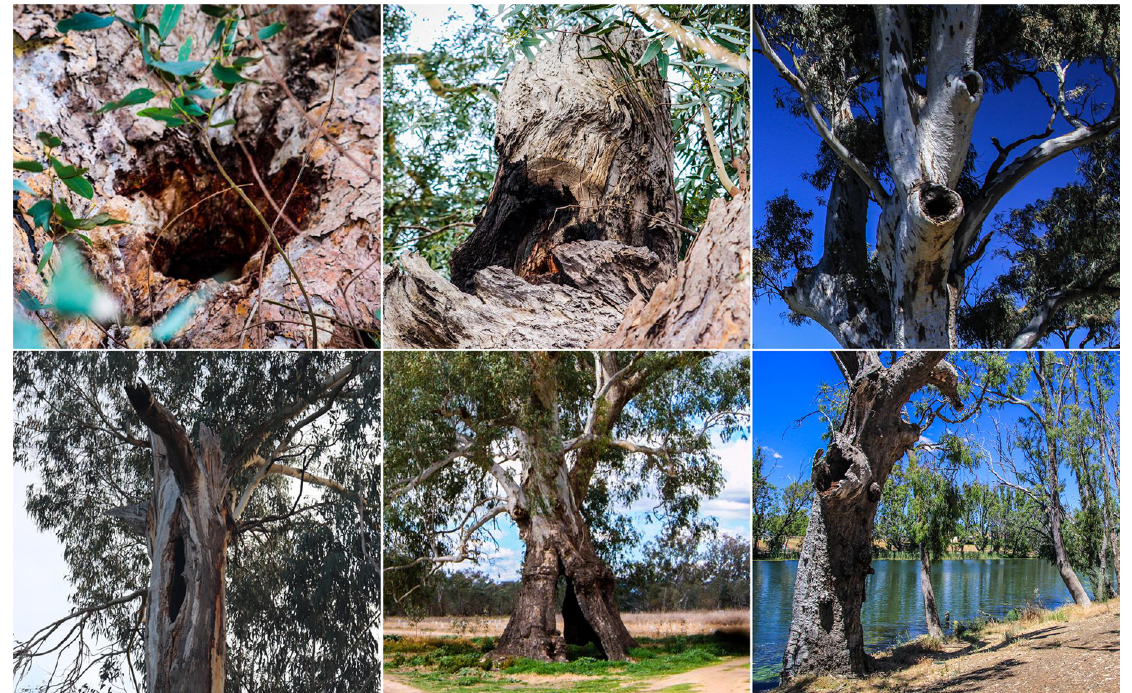
Fig. 5 Hollows in large old river red gums. Top left: a small cavity. Top middle: hollow from a lightning strike. Top right: a large hollow from fallen branches (image by Colin Judkins). Bottom left: a large fissure and a protruding hollow. Bottom middle: a root cavity enlarged by fire (image by Friends of the Albury Botanic Gardens). Bottom right: a snag with a large hollow and numerous entrances (image by Colin Judkins) (Source of all inattributed images: the